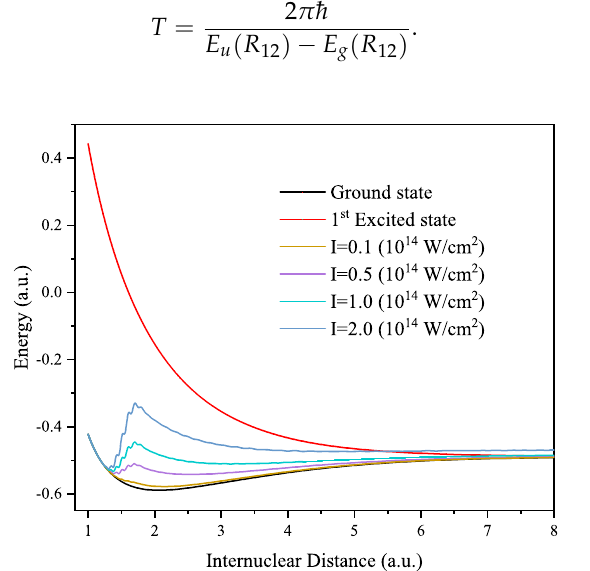
Figure 3. Potential energy curve of the electronic states of H + with different intensities compared to the ground state and the first excited state of the